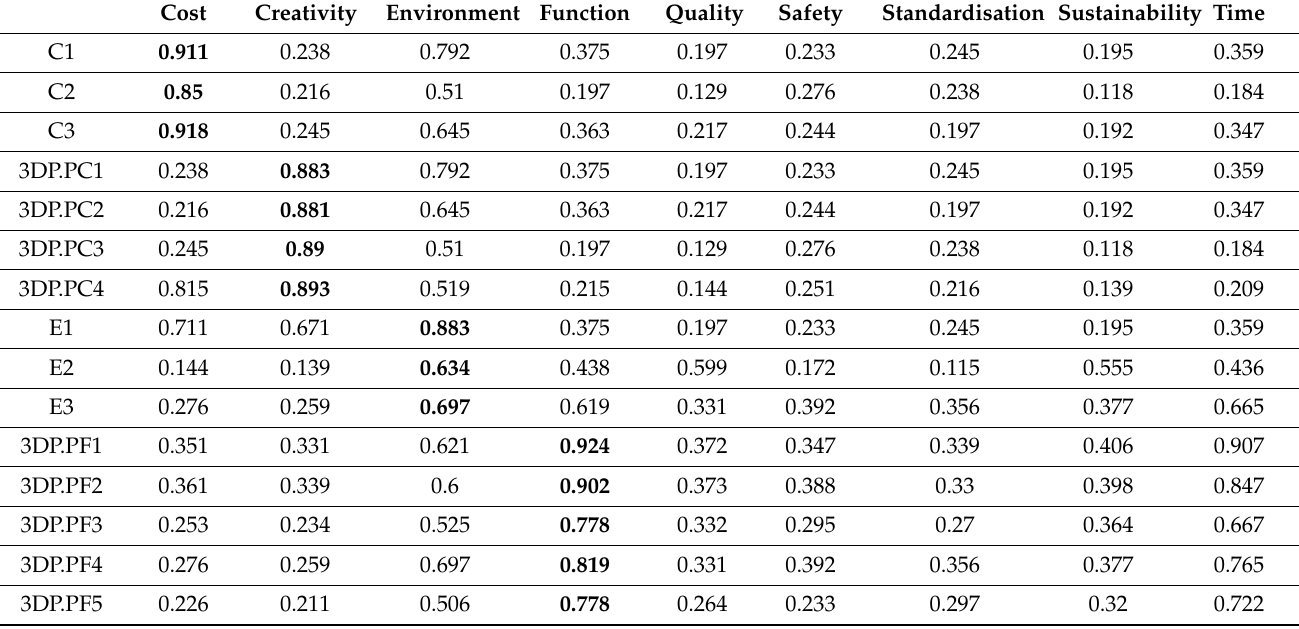
Table 7. Statistically determined cross-loadings for discriminant